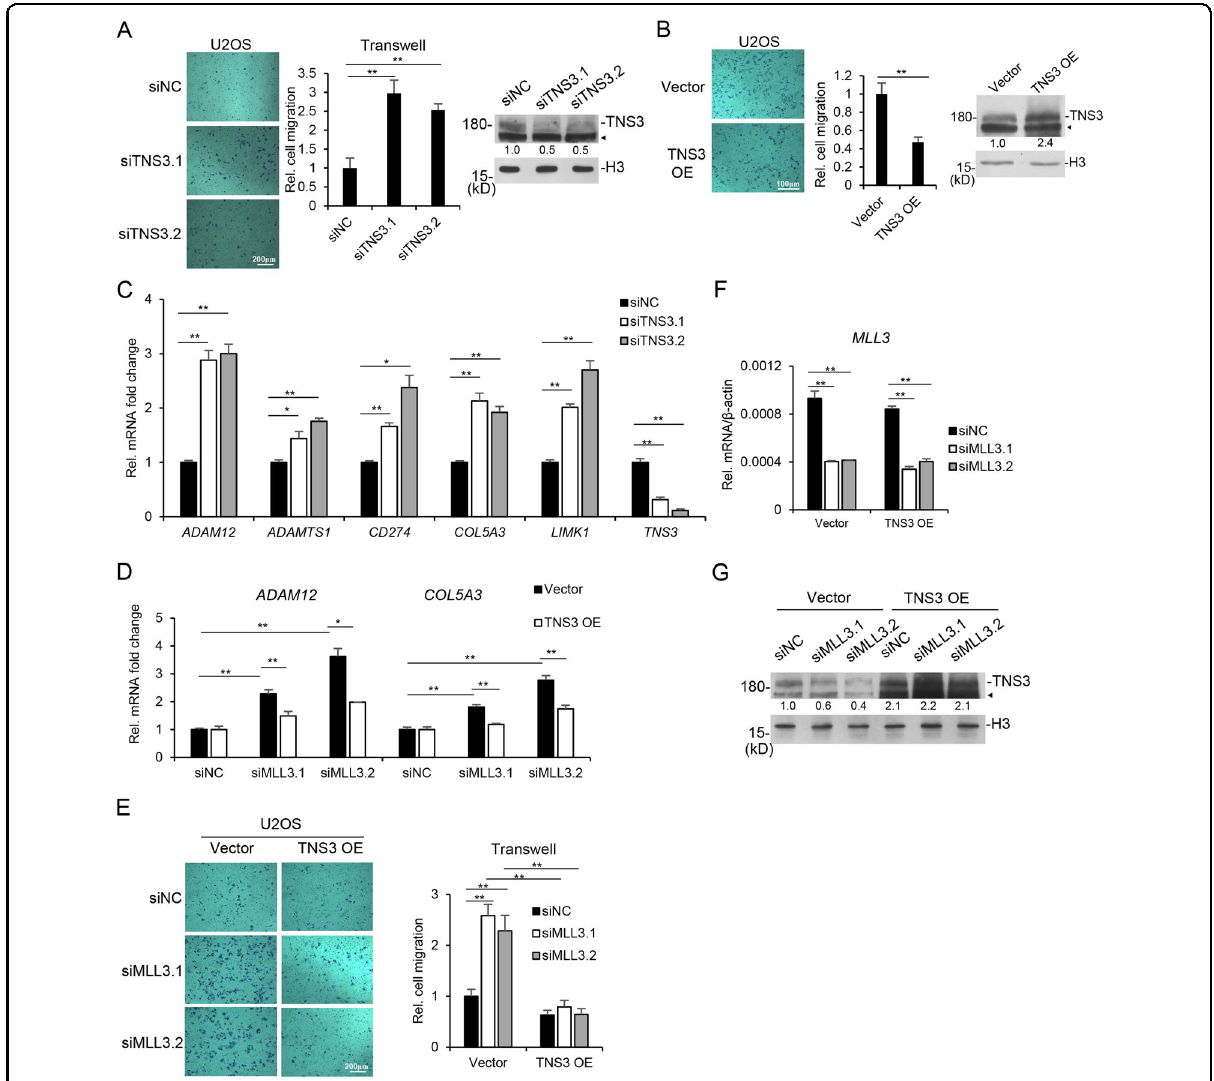
Fig. 5 MLL3 de fi ciency increased cell migration through TNS3. A TNS3 was knocked down with siRNAs in U2OS cells. Transwell assay was performed to show cell migration with or without TNS3. B TNS3 was exogenous expressed in U2OS cells, and transwell assay was performed to measure cell migration. TNS3 proteins were analyzed by western blotting with anti-TNS3 antibody. C TNS3 was knocked down with two different siRNAs, and the mRNA levels of ADAM12 , ADAMTS1 , CD274 , COL5A3 , LIMK1 , and TNS3 were determined by qRT-PCR. D MLL3 was knocked down and then TNS3 was exogenous expressed in U2OS cells. The mRNA levels of ADAM12 and COL5A3 were determined by qRT-PCR. E Cells were treated as ( D ) and transwell assay was performed to measure cell migration. Histogram showing the statistical calculation of relative cell migration. F , G MLL3 mRNA levels and TNS3 protein of the cells used in ( D , E ) were determined by qRT-PCR ( F ) and western blotting ( G ), respectively. All the data are presented as mean ± SD ( n = 3). * P < 0.05, ** P < 0.01. ◄ represents unspeci fi c